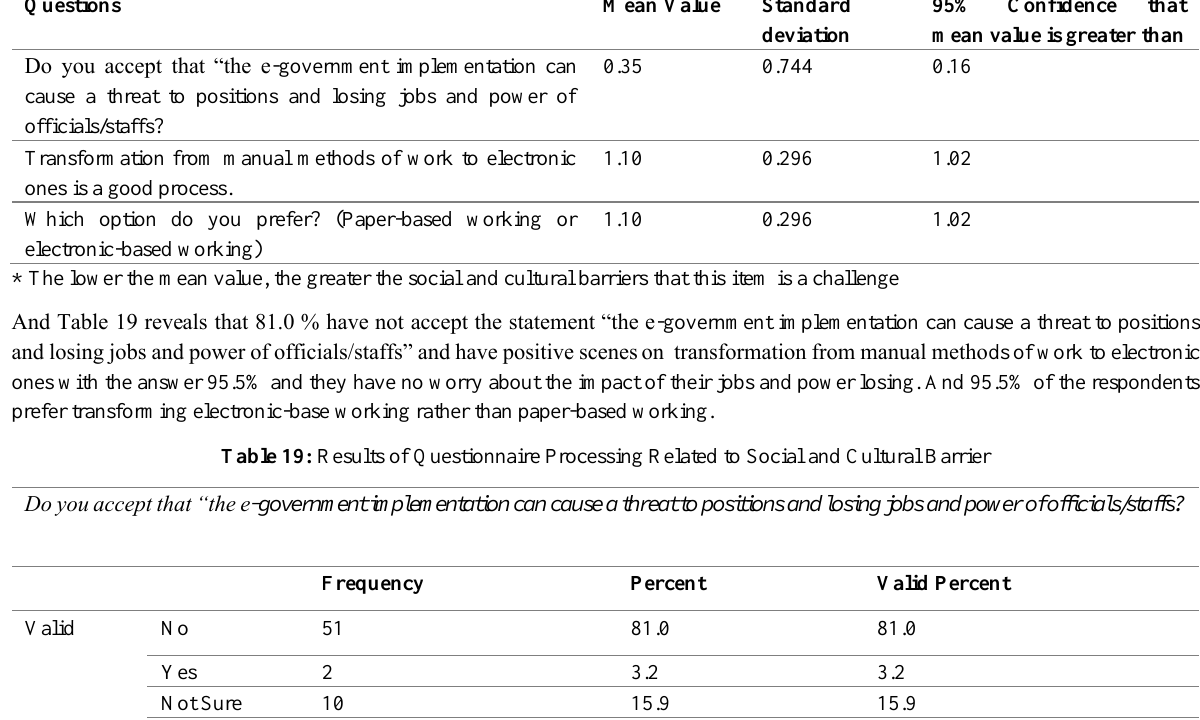
Table 18: Results of Questionnaire Processing Related to Social and Cultural Barriers Questions Mean Value Standard 95% Confidence that